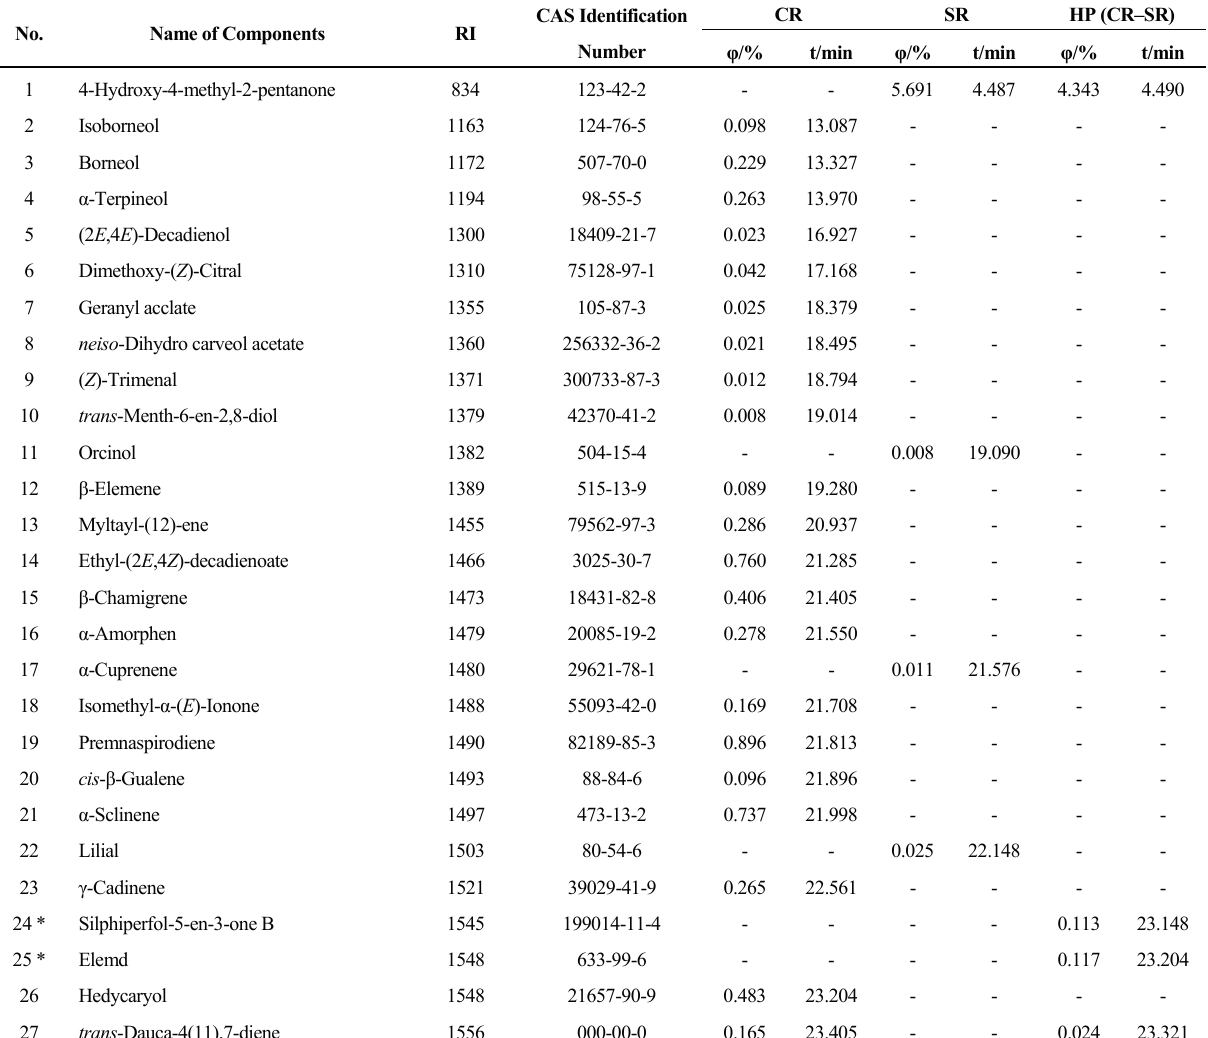
Table 1. Main chemical components of volatile oils from CR, SR, and HP